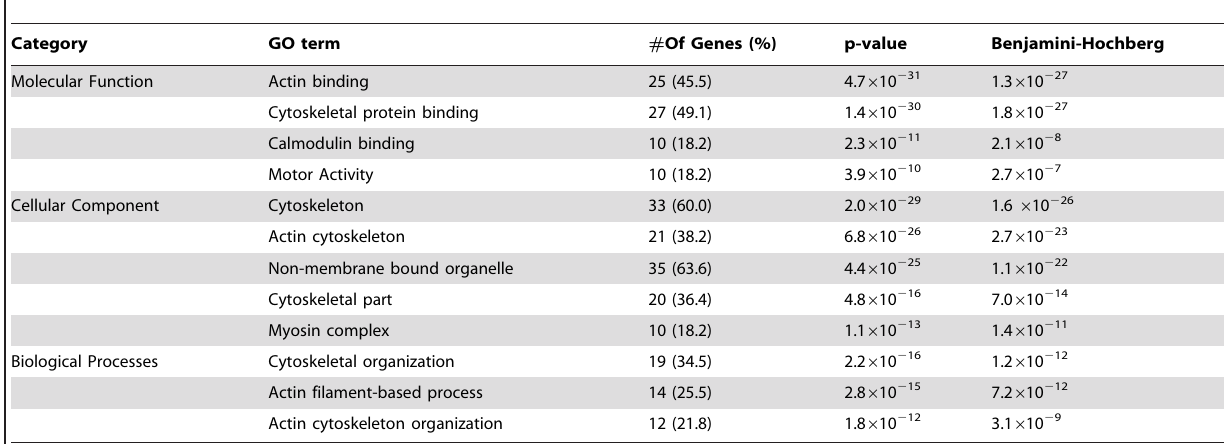
Table 2. Gene Ontogeny (GO)